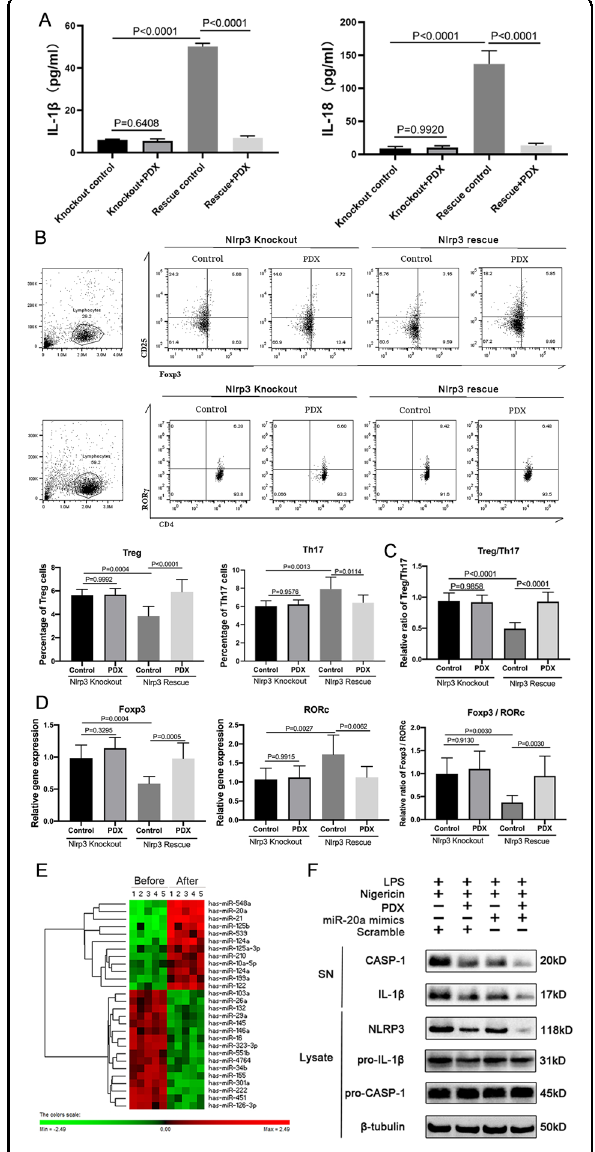
Fig. 6 PDX, regulated by miR-20a, restored Treg/Th17 cell balance in a rescue experiment involving Nlrp3 − / − CIA mice. A Concentrations of IL-1 β and IL-18 were detected in supernatant via ELISA. B Naive T cells were isolated and used as intervention in supernatant of PDX-treated BMDMs from NLRP3-rescued Nlrp 3 − / − CIA mice. Percentages of T h 17 cells and Tregs differentiated from naive T cells were detected via FCM. C Ratio of Tregs to T h 17 cells in the rescue experiment. D ROR γ and FOXP3 mRNA expression and FOXP3/ ROR γ ratio. E Heatmap analysis of different miRNA expression pro fi les in macrophages before and after PDX microarray treatment. F Concentrations of CASP-1, IL-1 β , NLRP3, pro – CASP-1, and pro – IL-1 β in miR-20a – transfected macrophages were detected via